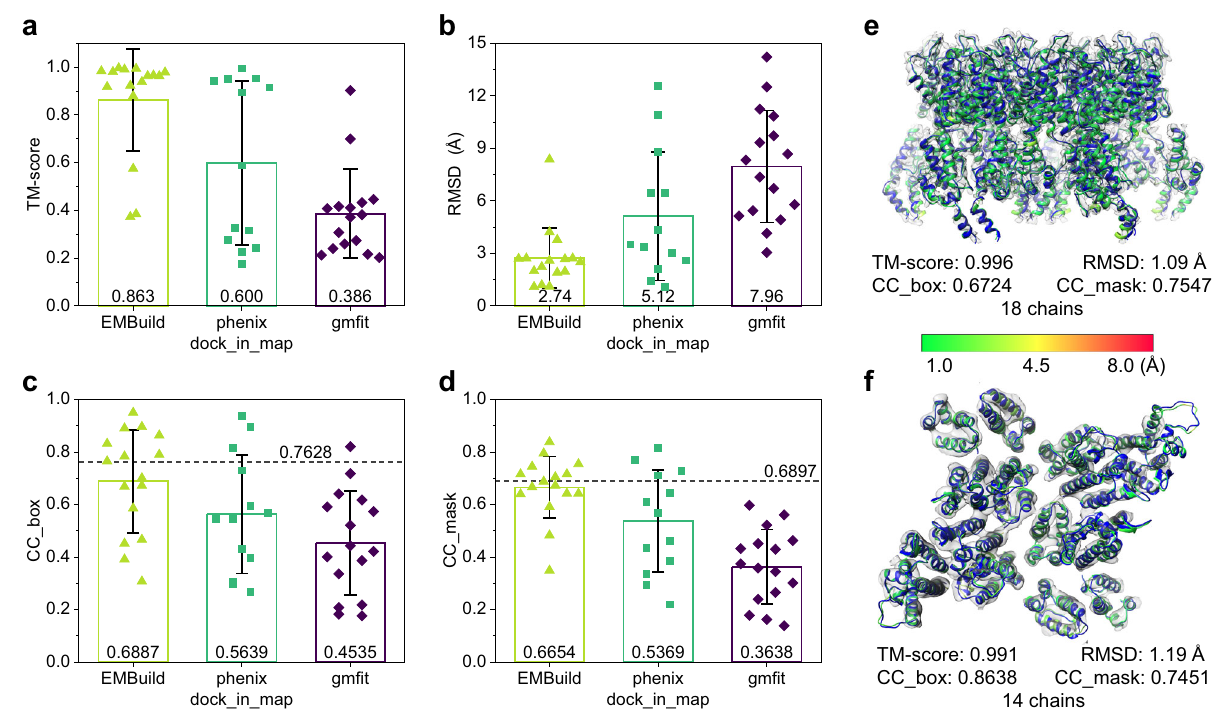
Fig. 6 Evaluation results on the test set of 16 EM maps obtained by subtomogram averaging of cryo-ET data. a – d Average TM-score ( a ), RMSD ( b ),